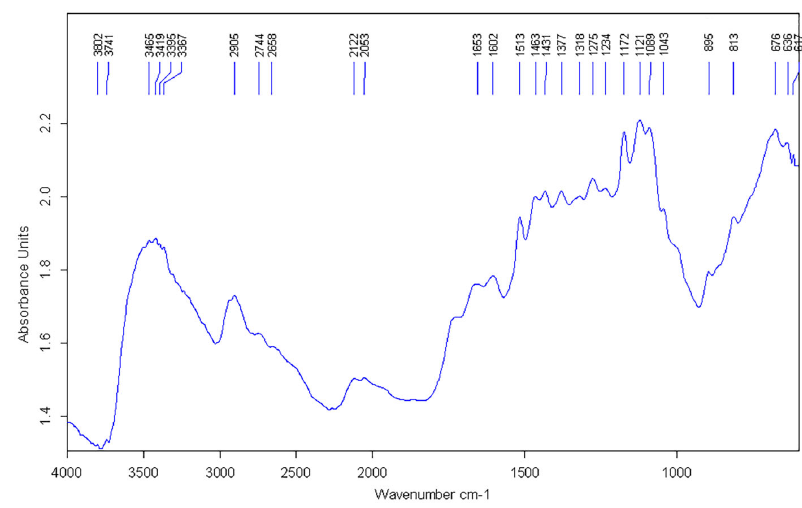
Figure 10. µ –FTIR spectrum of the wood sample from the upper cover. Figure 10. μ – FTIR spectrum of the wood sample from the upper cover. The peaks in the range 2906–2744 cm − 1 represent the deformation vibrations of the symmetric C–H bonds in cellulose and hemicellulose [23]. The variations of the FTIR spectra around the value of 2906 cm − 1 show that these absorption peaks increase with aging, the mechanism of which is based on the degradation process by oxidation and acid–base hydrolysis [33].